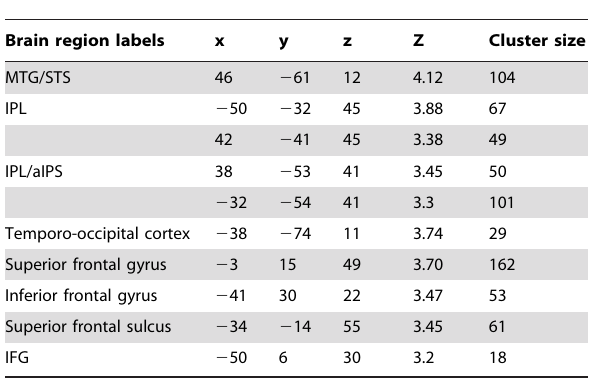
Table 2. Local Maxima in MNI coordinates of cerebral activations peaks from fMRI data for new intentions minus repeated intentions.